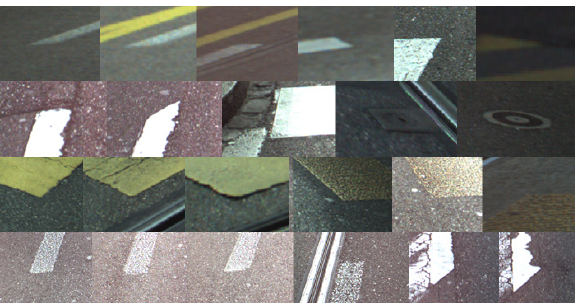
Figure 16. A sample for all 3D points of stereo image